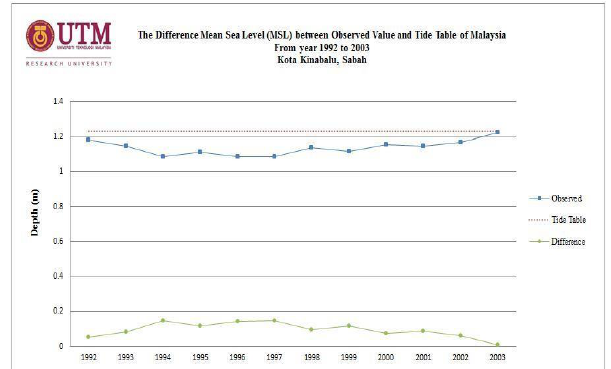
Figure 22. Graph of Difference Mean Sea Level (MSL) between Observed Value and Tide Table of Malaysia at Kota Kinabalu, Sabah.